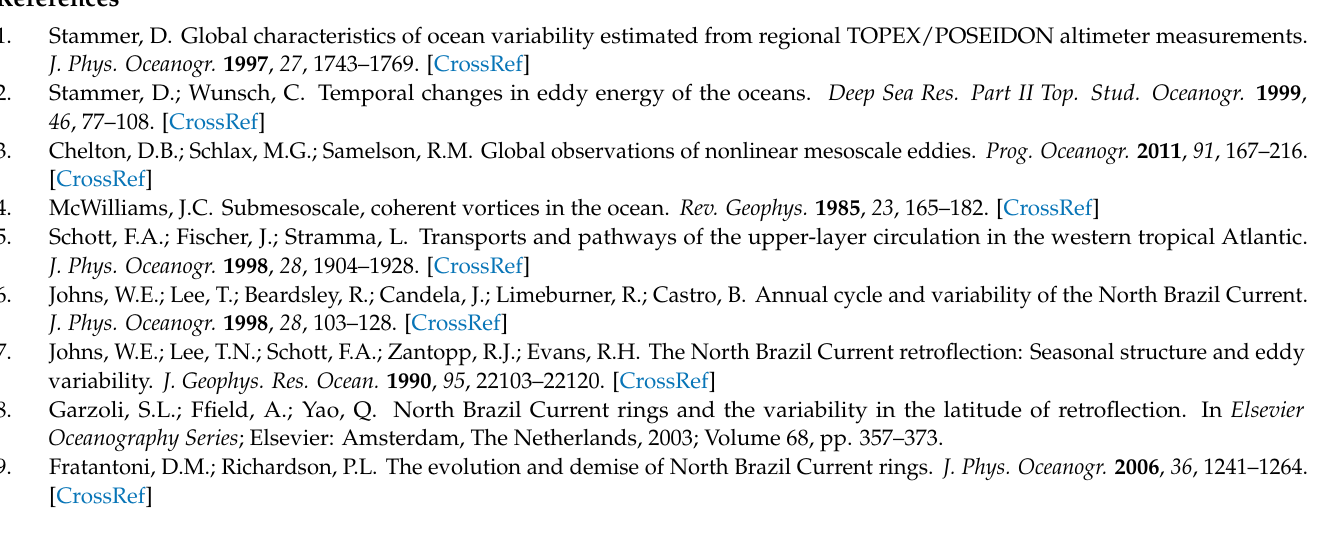
physical parameters over the 27 years of ADT fields. ( a ) Lifetime, ( b ) Radius max ( c ) Velocity max, ( d ) Normalized Rossby number, ( e ) Kinetic energy, ( f ) Amplitude, ( g ) Translation speed, ( h ) Distance covered. Figure S8: Ensemble mean and standard deviation of NBC rings parameters as a function of normalized lifetime. ( a ) translation speed, ( b ) Radius max ( c ) Velocity max, ( d ) Amplitude, ( e ) Kinetic energy, ( f ) Rossby number. Video S1: Evolution of the A2 contour detected on the daily ADT fields, with tracks of the main observing platforms deployed during EUREC 4